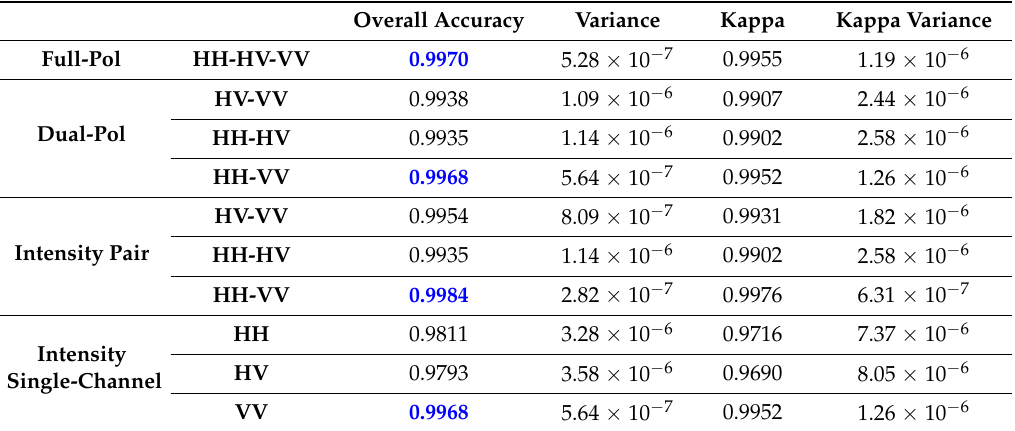
Table 1. Statistical evaluation of the classification